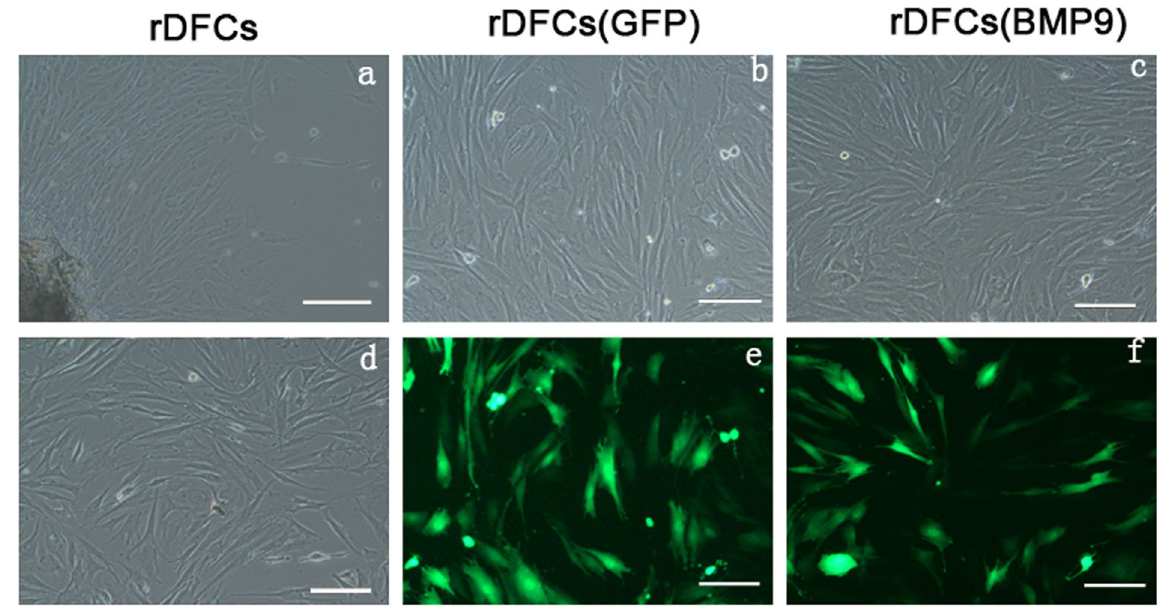
Figure 1. The primary rDFCs and rDFCs transfected by Ad-BMP9. The primary and the 3 rd passage rDFCs showed in Fig. 1a and d. The shape and fluorescence of rDFCs transfected with Ad-BMP9 or Ad-GFP was also showed in Fig. 1b,e,c and f. Blank bars: 50 μ